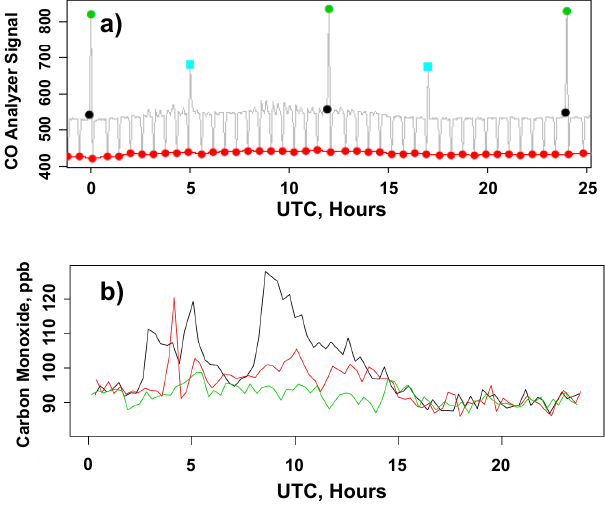
Fig. 2. (a) CO 2 analyzer signal for a typical summertime daily mea- Fig. 3. Same as Fig. 2 but for CO. The baseline measurements surement cycle at the LEF tall tower site (Park Falls, WI; 6 Au- (red = COZER) correspond to scrubbed ambient air. The analyzer gust 2009). The analyzer signal is the estimated mole fraction differ- signal is the estimated mole fraction in ppb based on the factory ence from the reference gas based on the factory calibration. Filled calibration. Note that it is normal for the signal from this type of circles correspond to calibration standards (black = C1, red = C2, analyzer to drift upward, which is the reason for the high values in green = C3, dark blue = C4). Red connecting lines show the contin- (a) . Since we do not rely on the factory calibration, we do not need uous estimate of the analyzer baseline. Target (TGT) measurements to adjust the analyzer zero (cyan squares) are treated as unknowns and used to monitor sys- tem performance. (b) Corresponding χ CO time series for the 30m 2 (black), 122m (red), and 396m (green) sampling heights showing well-mixed conditions during afternoon and stratified conditions at night. Local standard time for the LEF site is 6h behind GMT.